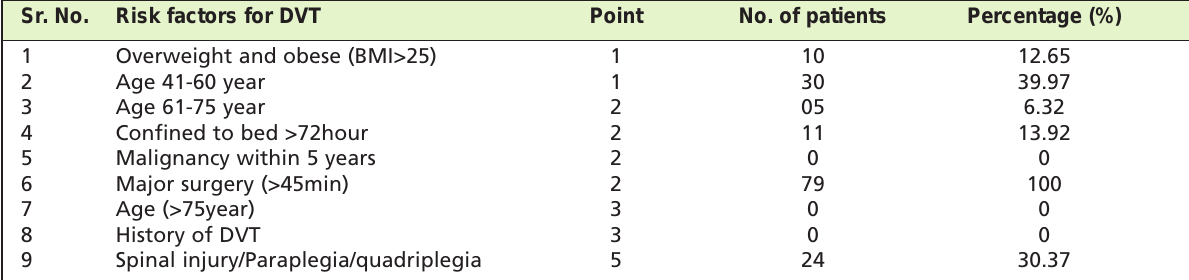
Distribution of patients according to risk factors (to segregate the patients in high, intermediate and Table III: low risk group for DVT) Sr.